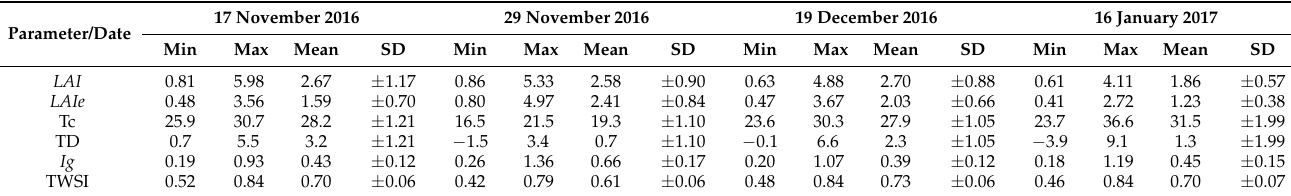
Table 1. Growth and water stress parameters obtained using the proposed urban tree monitoring system, measured at Royal Parade in Melbourne, Australia, for four measurement surveys between 2016 and 2017. Parameters are presented with maximum, minimum, means, and standard deviation values (SD) for leaf area index ( LAI , adimensional), effective LAI ( LAIe , adimensional), canopy temperature of trees (Tc, ◦ C), temperature depression (TD, ◦ C), thermal infrared index ( Ig , adimensional), and tree water stress index (TWSI, adimensional).